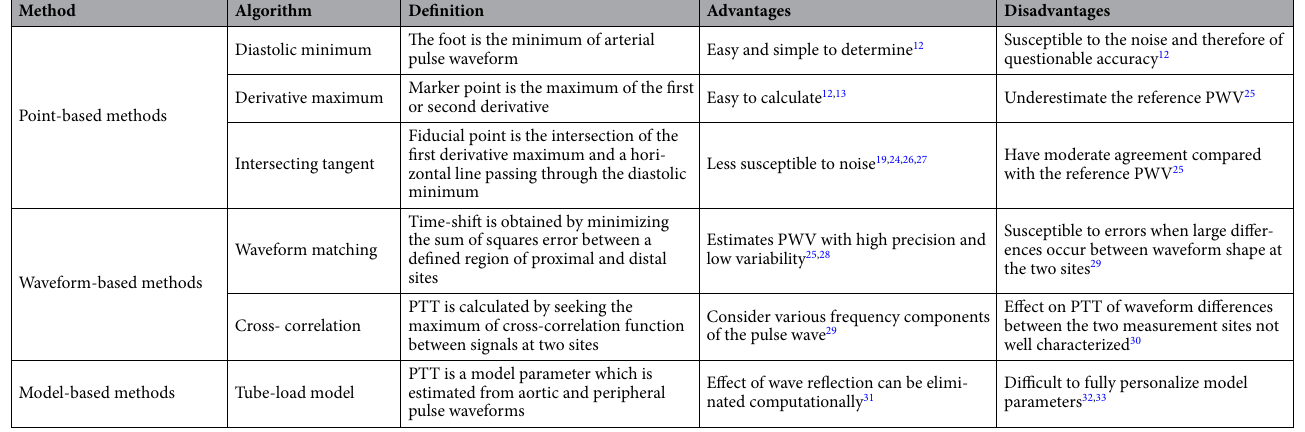
Table 1. Summary of some methods for calculating arterial